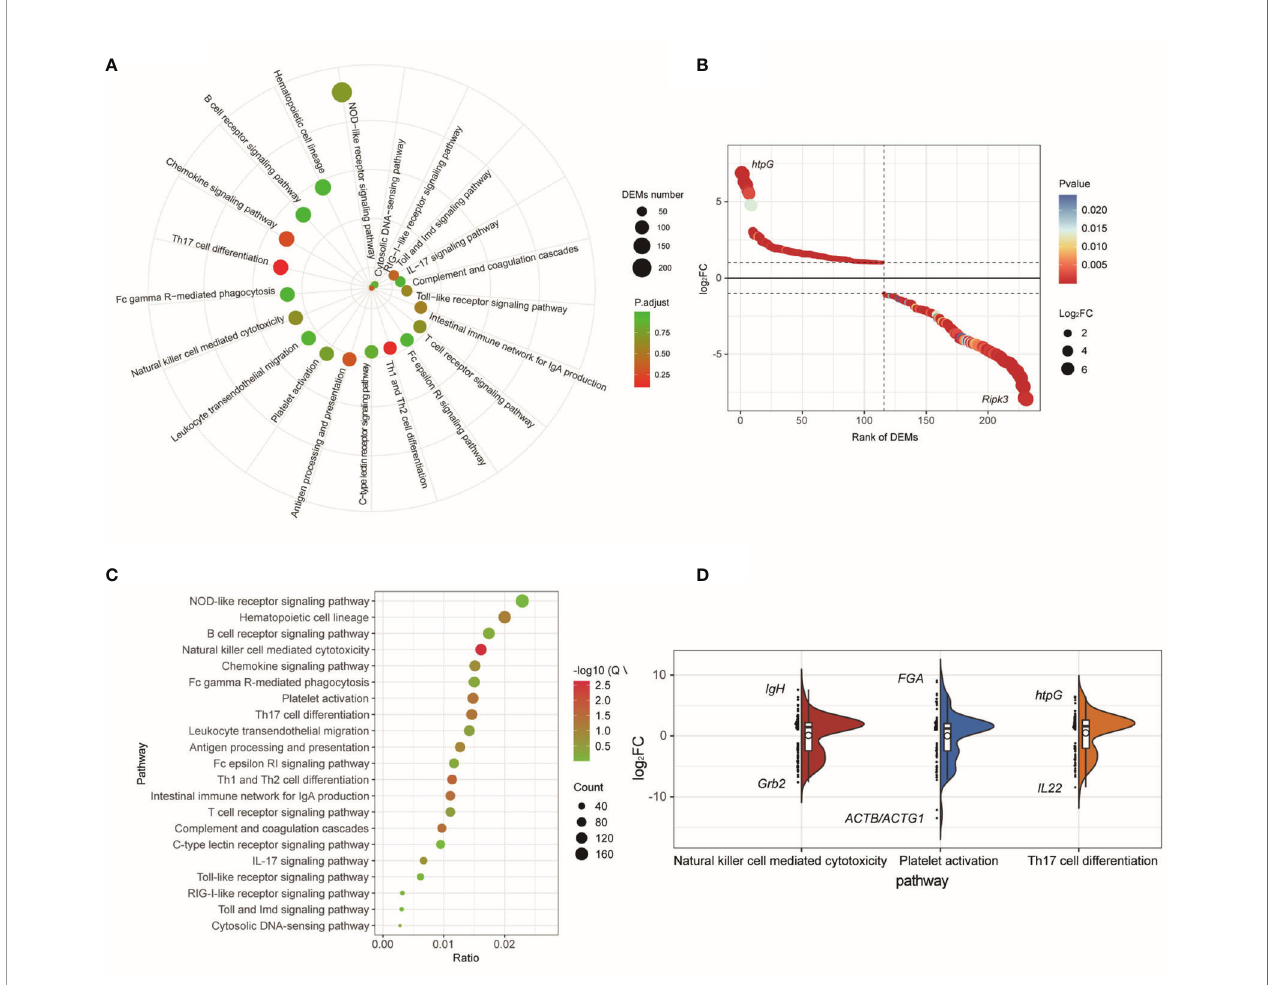
FIGURE 6 | KEGG enrichment analysis of comparative transcriptome of fl iK -RNAi and WT strain infection groups (3 and 5 dpi). (A) Signaling pathways related to immune system in comparative transcriptomes of fl iK -RNAi and WT strain infection groups (3 dpi). (B) Expression level of DEGs in NOD-like receptor signaling pathway. (C) Signaling pathways related to immune system in comparative transcriptomes of fl iK -RNAi and WT strain infection groups (5 dpi). (D) Expression level of DEGs in NK cell-mediated cytotoxicity, platelet activation, and Th17 cell differentiation (black horizontal lines in boxes show median expression level of each mRNA. Upper and lower frames in white box represent upper and lower quartiles in dataset, respectively. Left side re fl ects distribution of data, right side re fl ects data density, black mark indicates most up-regulated and down-regulated mRNA expression level in each